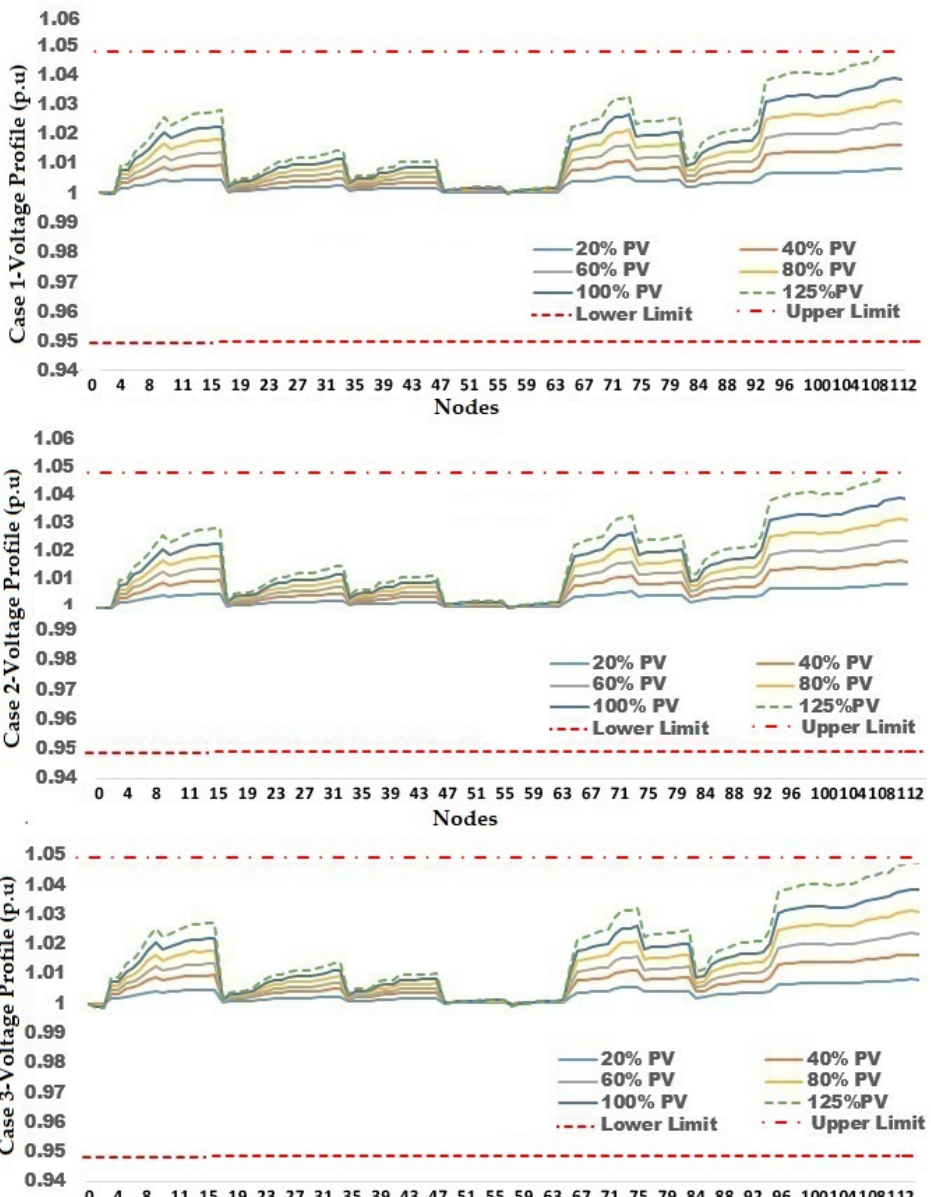
Figure 3. Comparing voltage profiles during no-load conditions for three case studies.